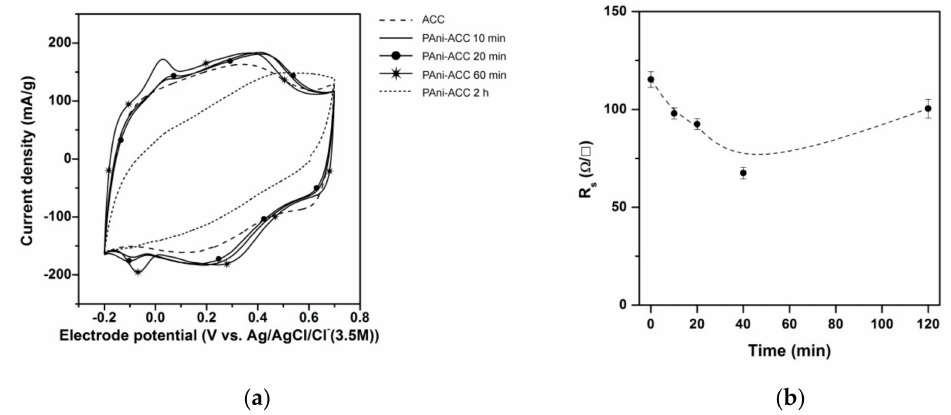
Figure 9. ( a ) Stabilized cyclic voltammograms of untreated ACC and hybrid PANi-ACC